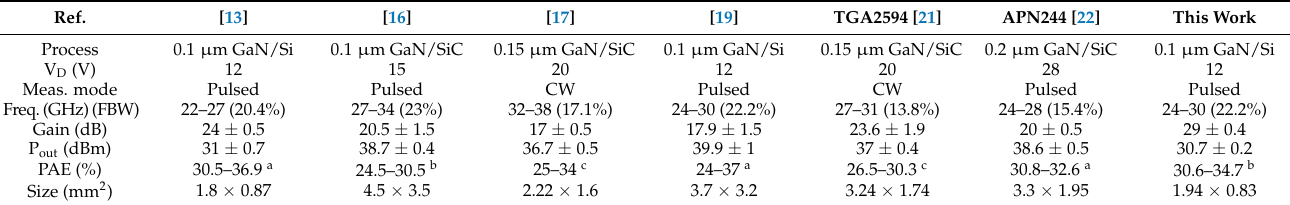
Table 4. Performance summary and comparisons with previous